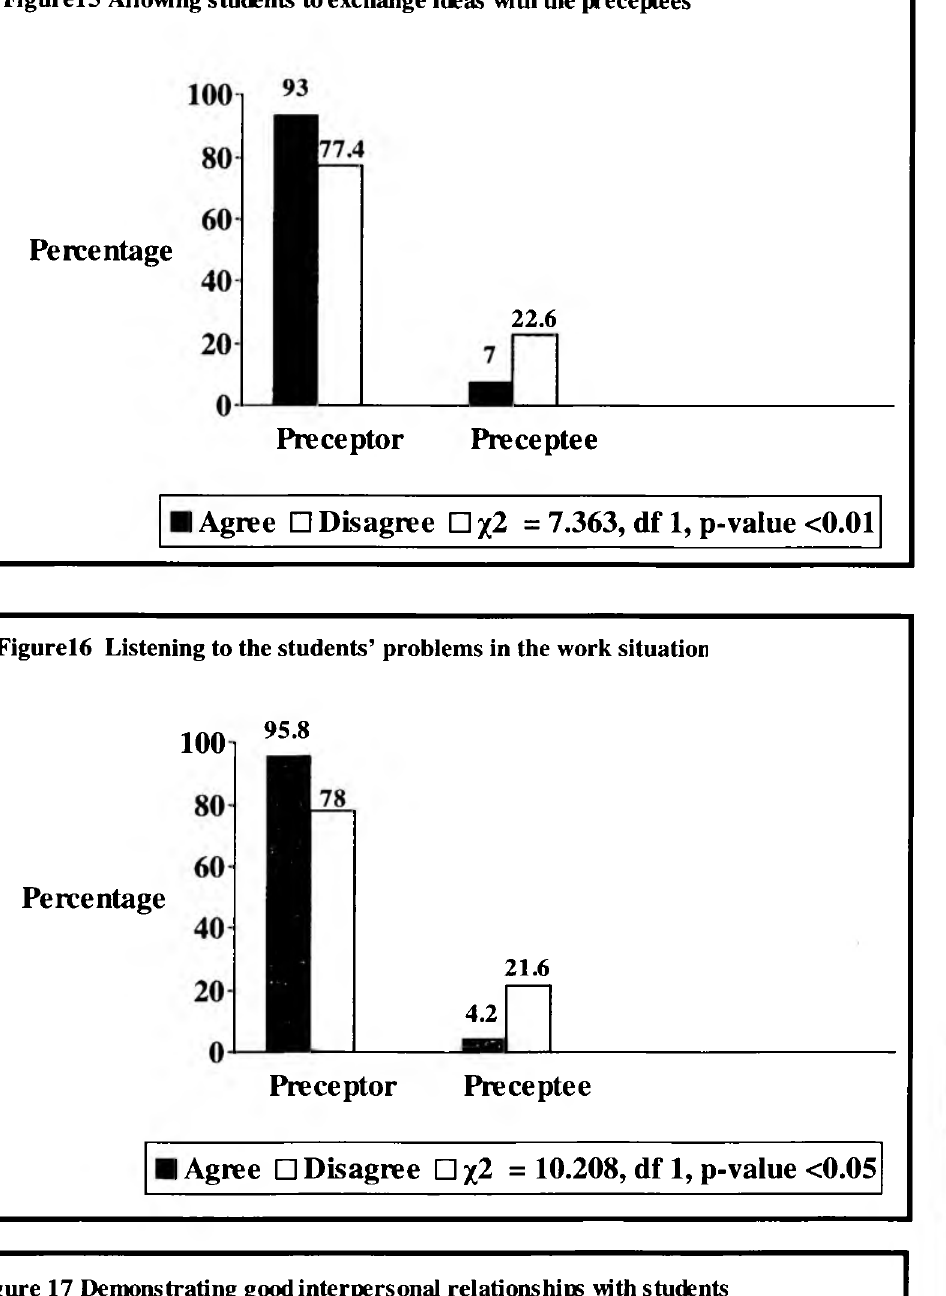
Figure 17 Demonstrating good interpersonal relationships with